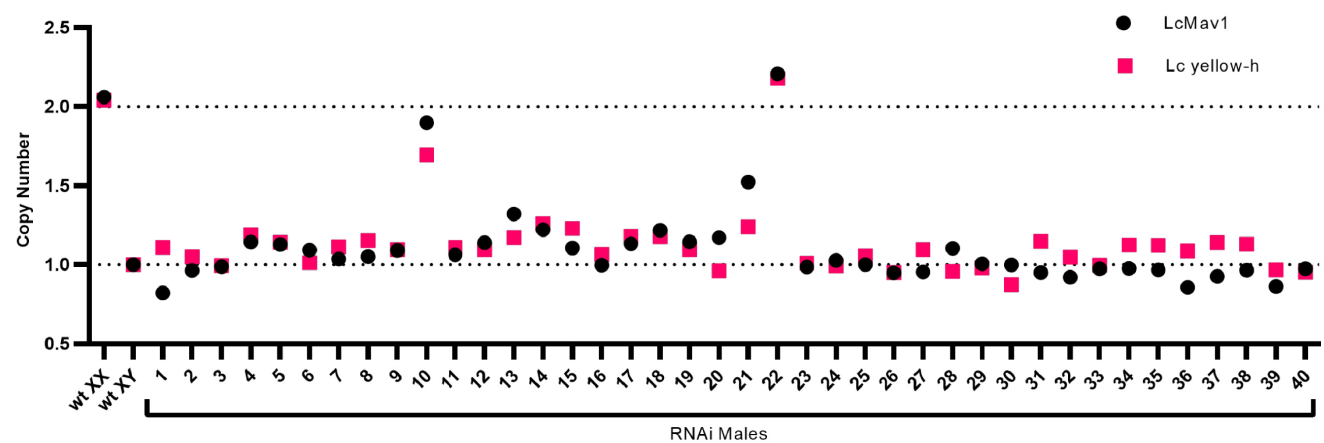
Fig 4. Few transformed DR3#6 LctraIR7 XX flies survive to the adult stage. qPCR analysis genotyping 40 adult DR3#6; LctraIR7 phenotypic males using two different X-linked genes- LcMav1 and Lc yellow-h . RNAi males with a copy number ~1 are classified as XY while RNAi males with a copy number ~2 are classified as XX. Wildtype XX and XY adults used as control. Sample 10 and Sample 22 were found to be significantly different than the male control sample ( P < 0.0001, Tukey’s HSD) at both genes, while no significant difference was noted between these samples and the female controls ( P > 0.05) in both genes.